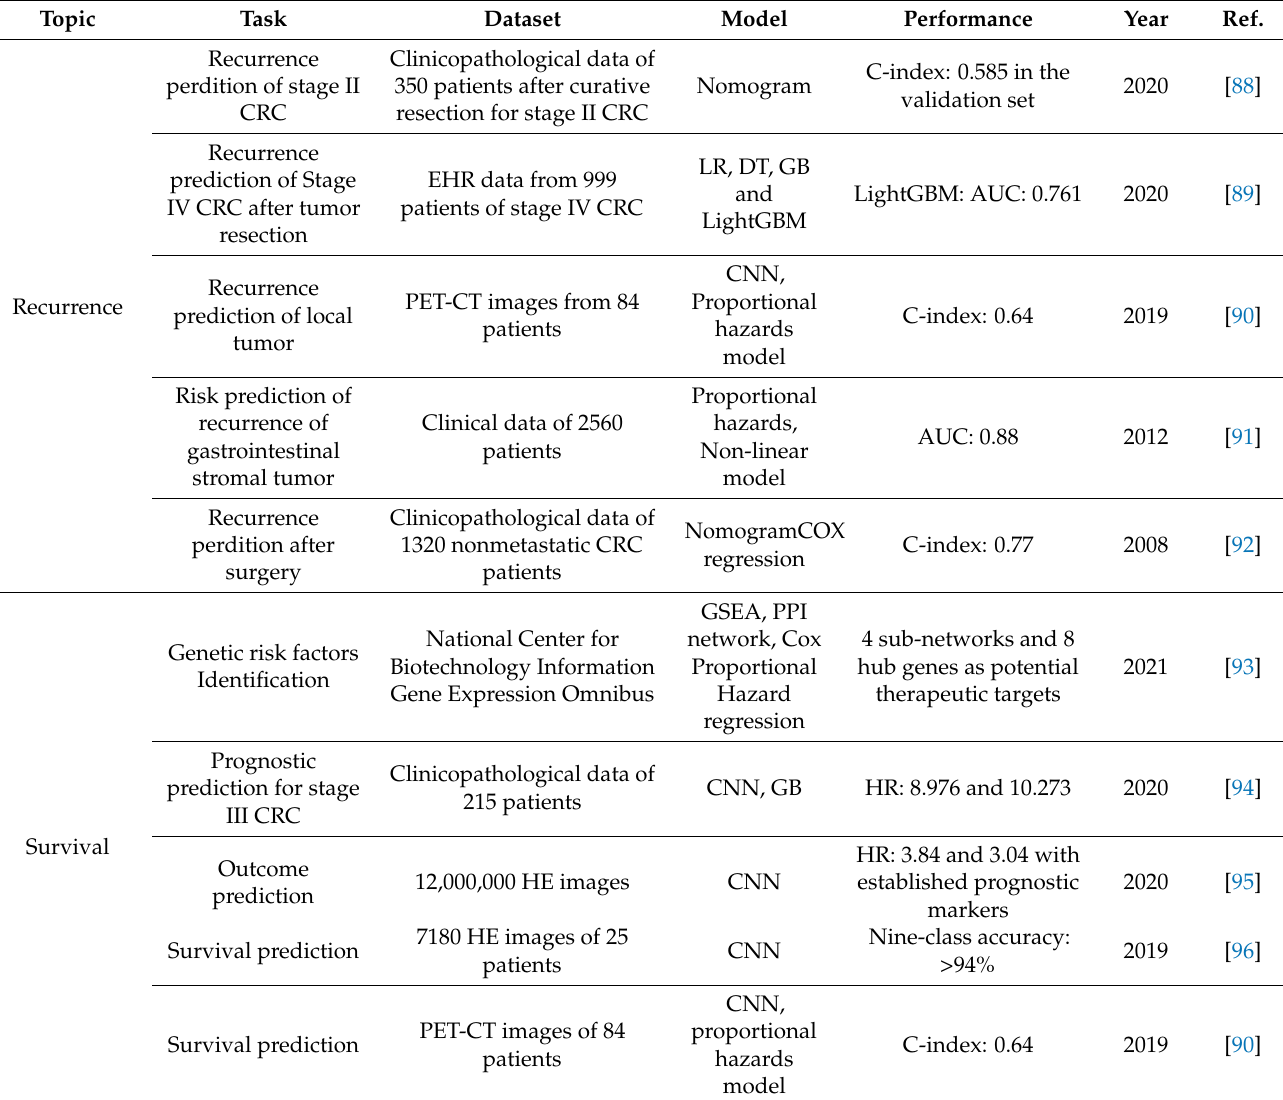
Table 4. Summary of AI models for CRC prognosis session. (C-index, concordance index; LR, logistic regression; DT, decision tree; GB, gradient boosting; LightGBM, light gradient boosting machine; CNN, convolutional neural network; AUC, area under curve; PET-CT, positron emission tomography or computed tomography; HR, hazard ratio; GSEA, gene set enrichment analysis; PPI, protein-protein interaction; HE, hematoxylin and eosin; WSI, whole slide image; MLP, multilayer perceptron; AdaBoost, adaptive boosting; LSTM, long short-term memory; EHR, electronic health record; SVM, support vector machine; NB, naïve Bayesian; KNN, K-nearest neighbors; NN, neural network; RF, random